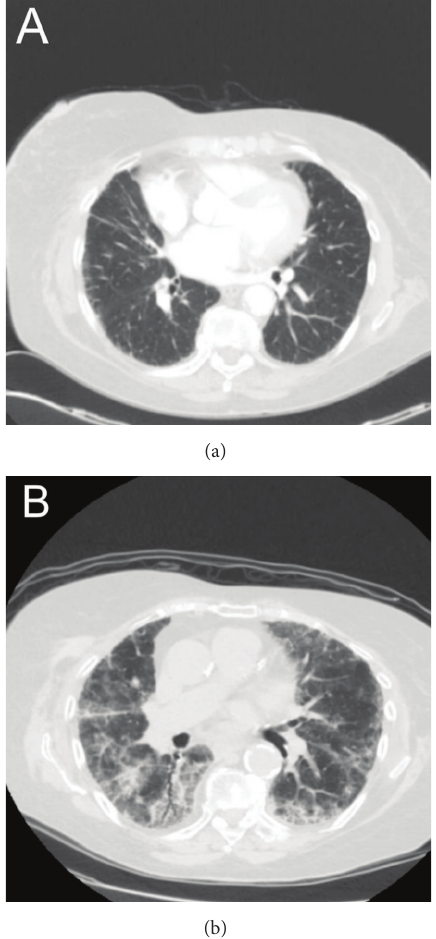
Figure 1: Lateral (a) and frontal (b) views show skin hyperpigmen- tation of the right temporal region with edematous appearance.